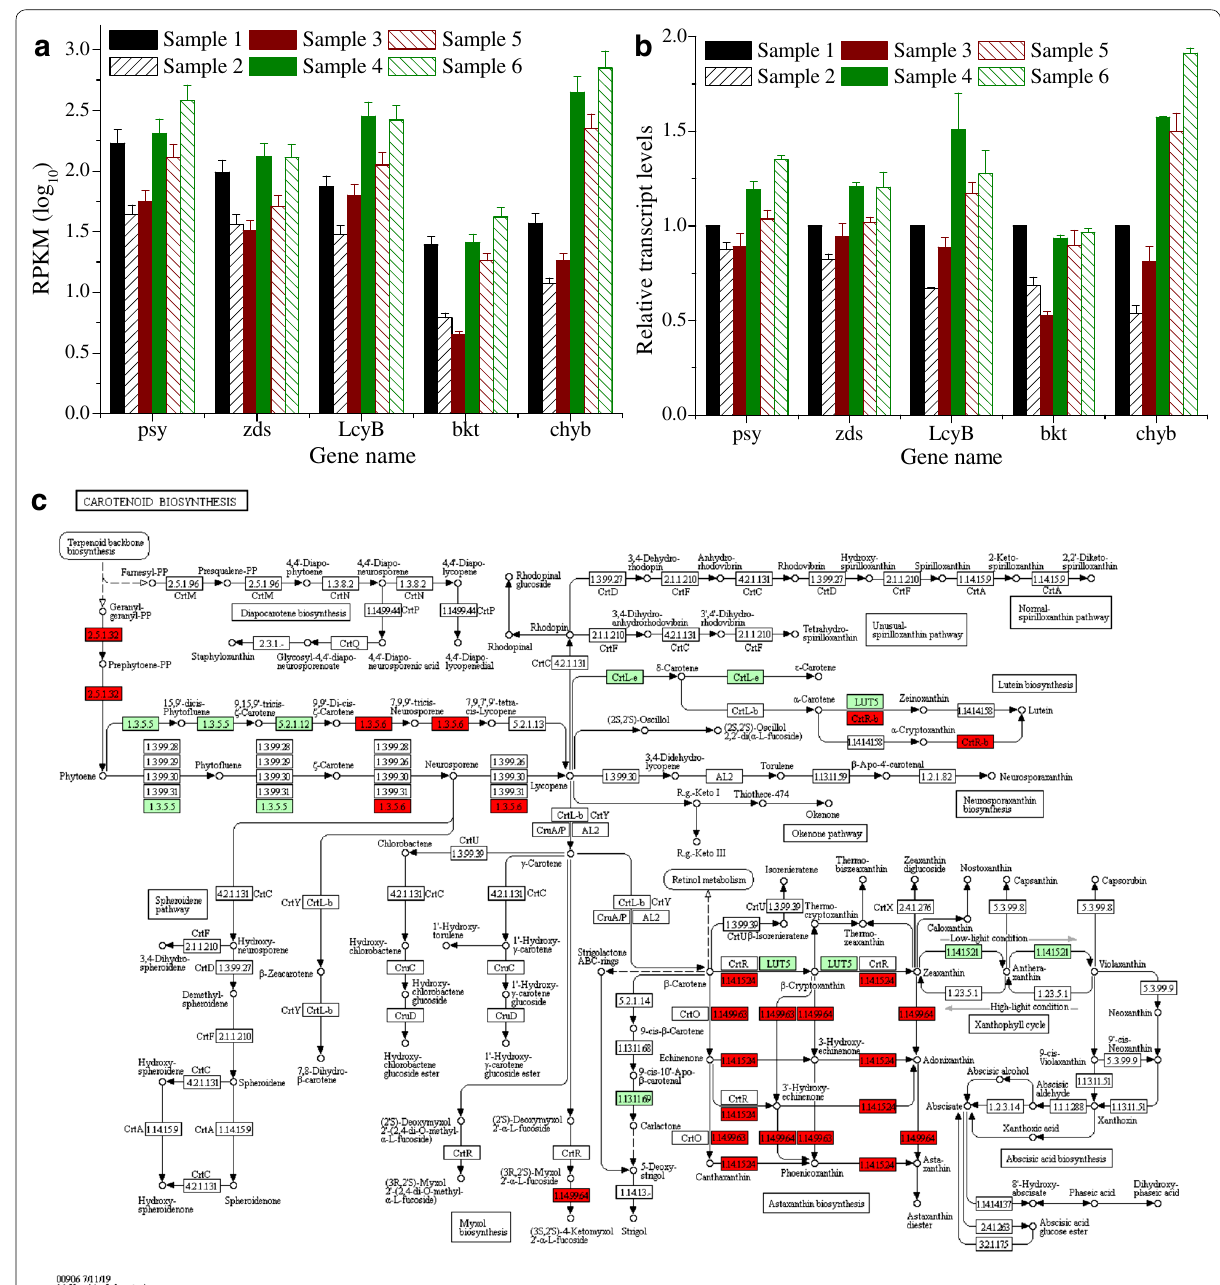
Fig. 5 RPKM and unigene transcription changes involved in astaxanthin biosynthesis pathways of H . pluvialis . a , b represent RPKM changes ( a ) and relative transcript level changes ( b ) involved in astaxanthin biosynthesis pathways of H . pluvialis in control group (1235 route) and treatment group (1246 route), respectively. To calculate genes transcript level, Sample 1 was regarded as control; comparing with control group (1235 route), the gene transcription changes of the treatment group (1246 route) were presented in KEGG pathway ( c ). Sample 1, Sample 2 and Sample 3 were the heterotrophic cells at 100 h, 250 h, and 550 h, respectively; Sample 4 was Sample 2 cells induction for 0.5 day; Sample 5 was Sample 3 cells induction for 6 days; Sample 6 was the Sample 2 cells induction for 6 days. Data shown as mean